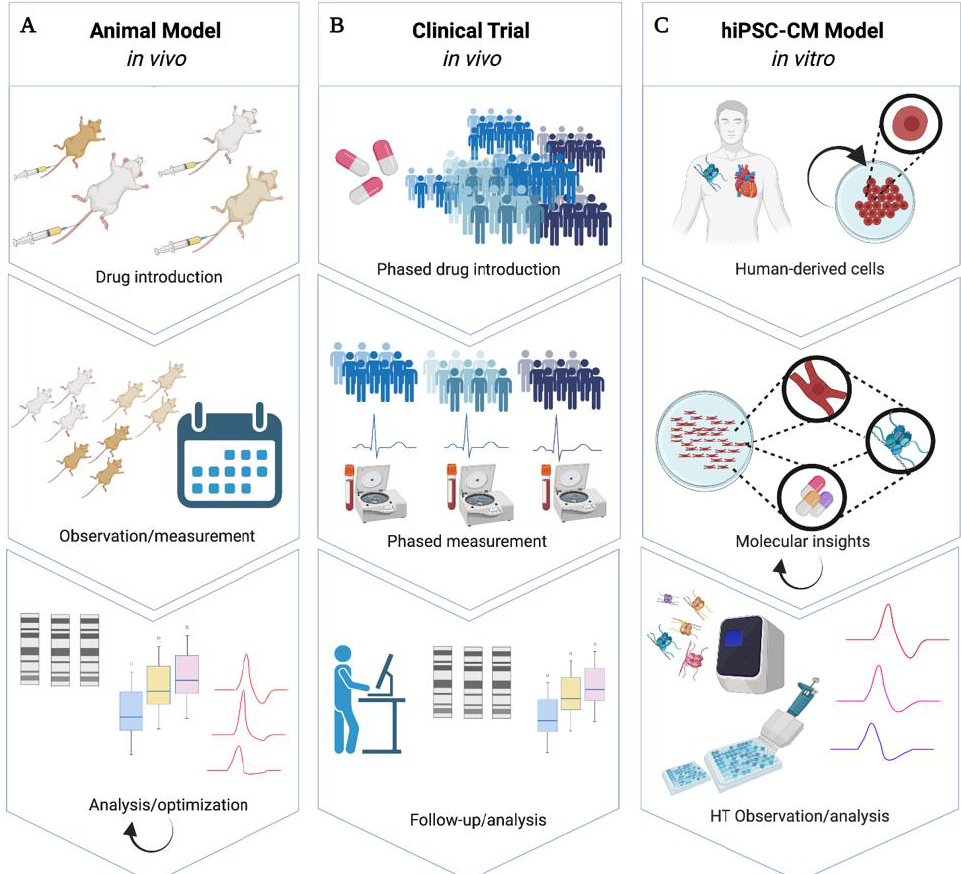
Figure 1. Three main methods of extracting epigenetic information surrounding drug introduction: ( A ) Animal experiments allow chronic observation and biomarker measurement upon drug administration, culminating in postmortem sample collection. ( B ) Multigroup drug introduction in humans is followed by periodic observation and biomarker collection culminating in biomarker analysis and in-person follow-up. ( C ) Patient-derived hiPSC-CMs are used to observe pharmacological cardiac effects in long-term, high-throughput optical and chemical modalities with feedback ability from existing in vitro assays for the direct improvement of future therapy. Created with Biorender.com.